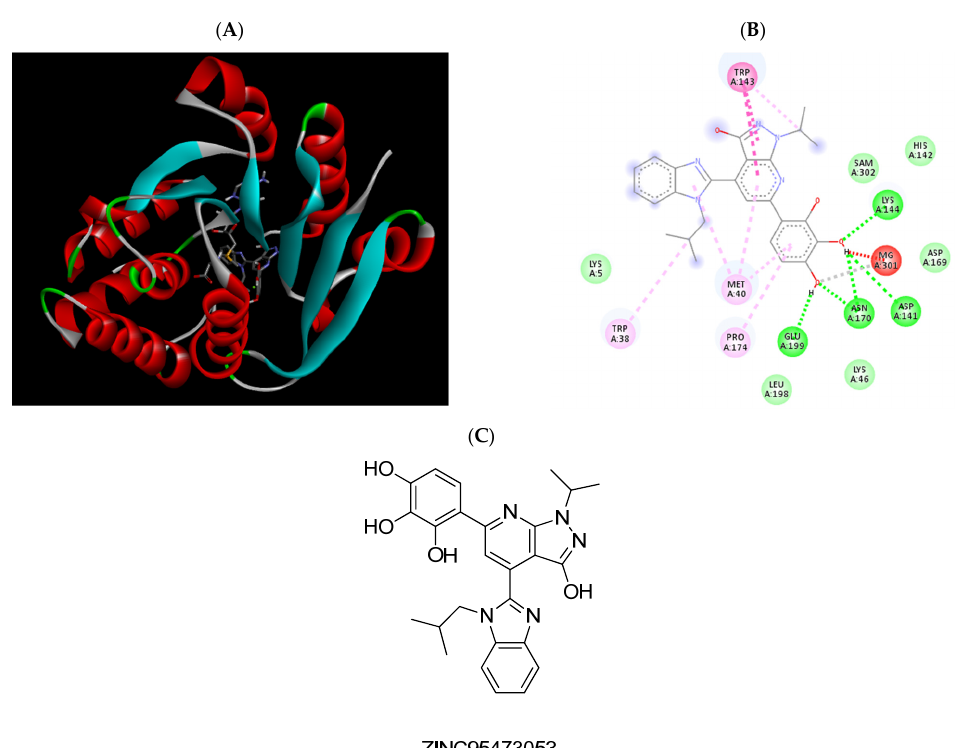
Figure 6. ( A ) Binding modes of ZINC95473053 with the crystal structure of human COMT complexed with SAM and Mg 2+ , ( B ) receptor–ligand interactions, ( C ) 2D representation of ZINC95473053.